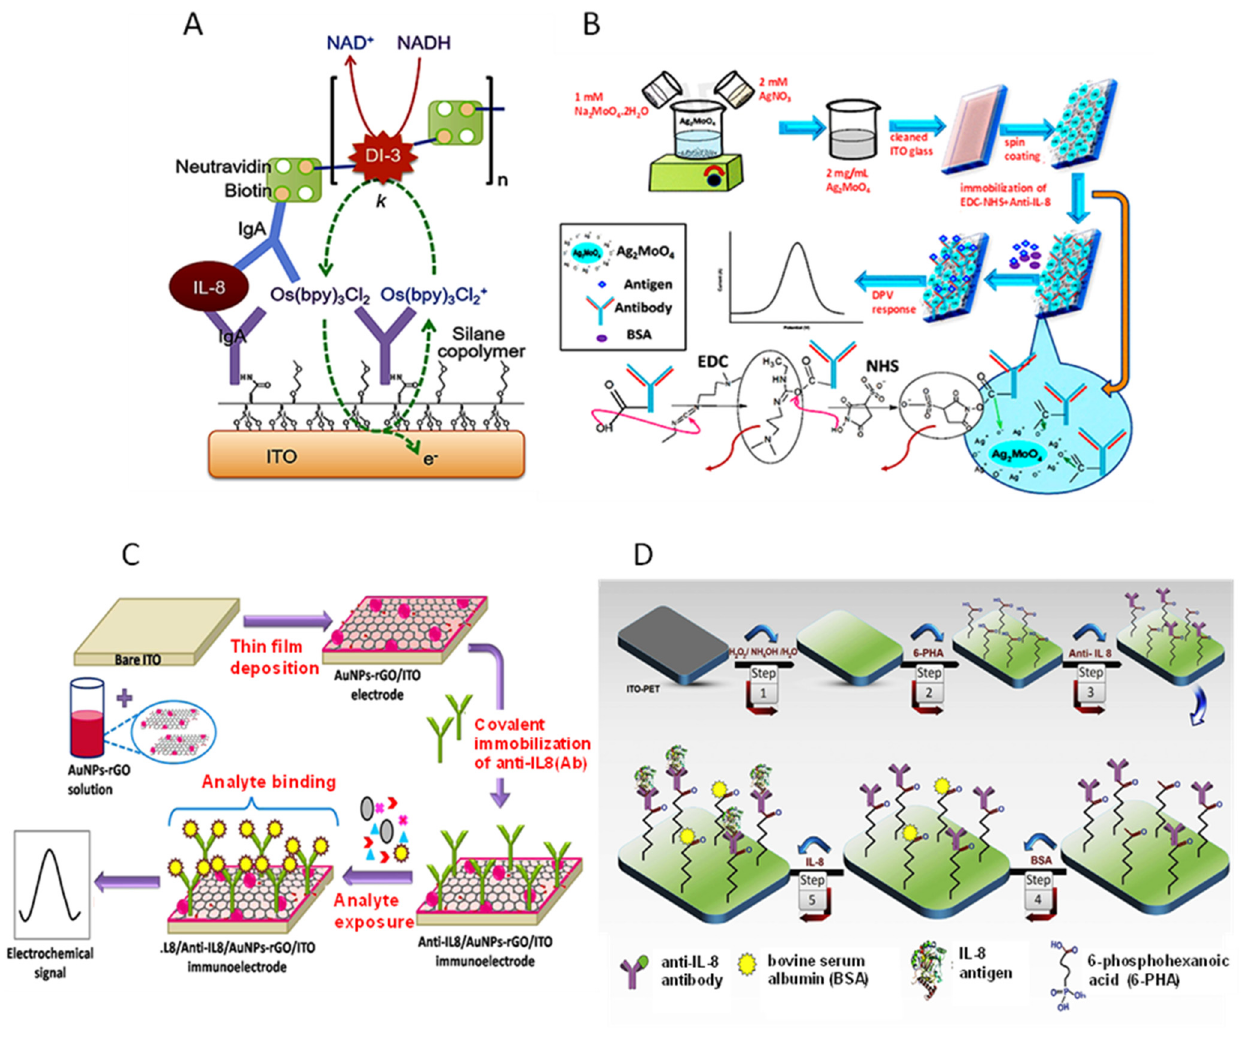
Figure 7. Schematic illustrations of some electrochemical immunosensors for the determination of IL-8: ( A ) a sandwich-type immunoassay using a polyenzyme label on diaphorase (DI-3) and neutravidin; ( B ) the synthesis of β -Ag 2 -MoO 4 NPs and immunoelectrode fabrication; ( C ) fabrication of an AuNPs-rGO based immunosensor; ( D ) steps for preparation of an impedimetric immunosensor. Reprinted from ( A ) [101], ( B ) [102]; ( C ) [103] and ( D ) [104] with permission.